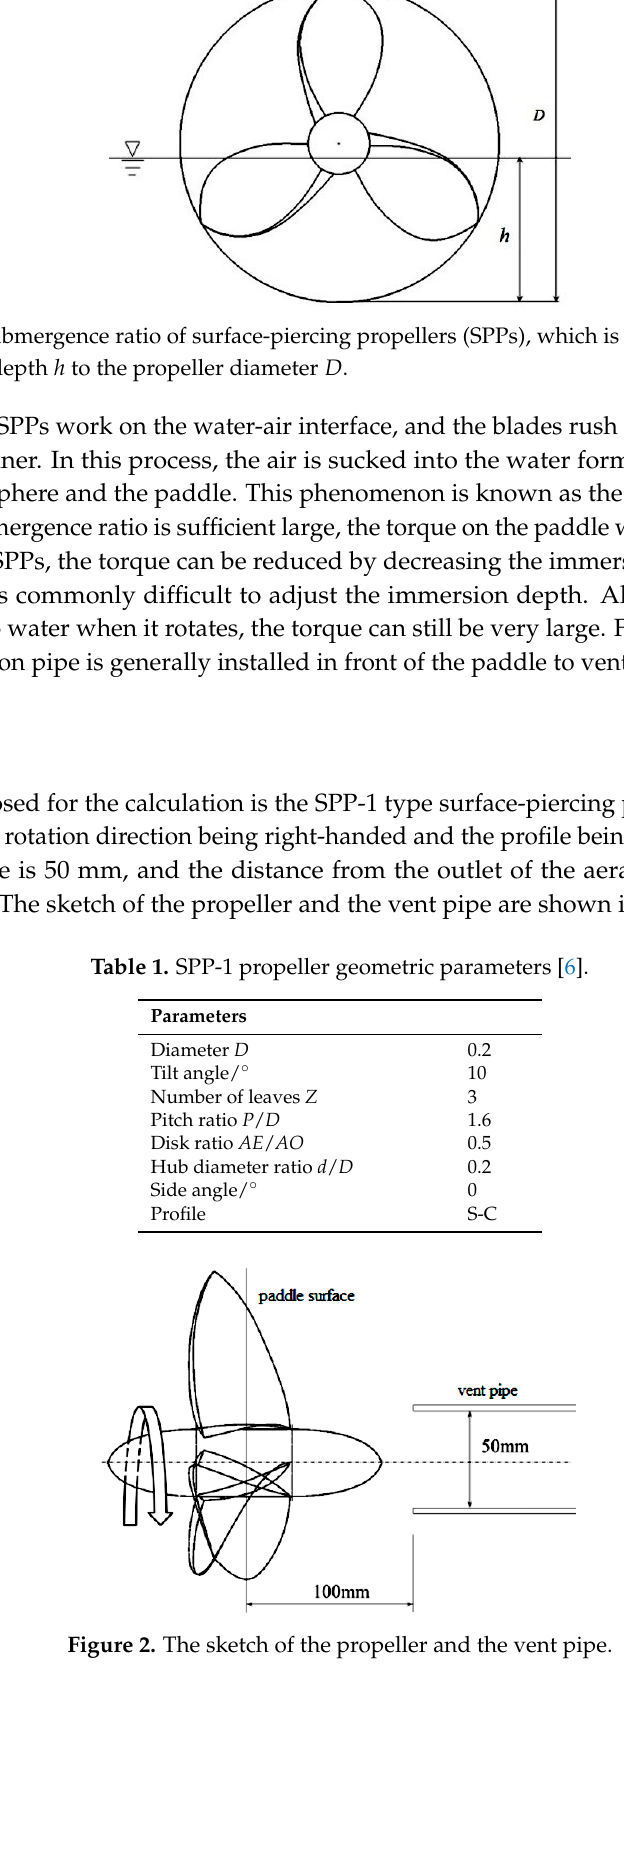
Figure 2. The sketch of the propeller and the vent pipe.